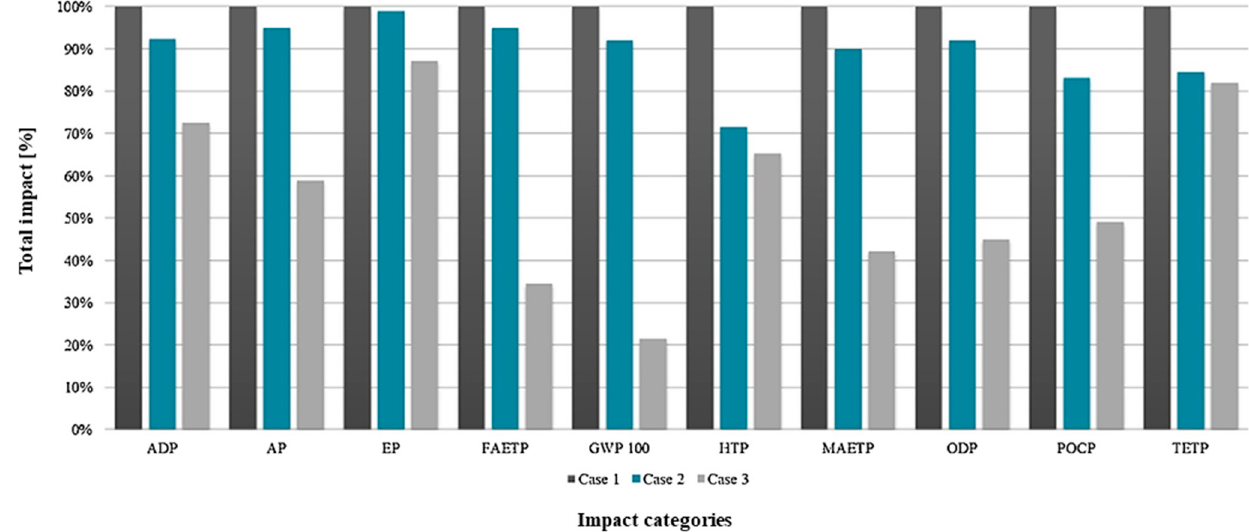
Figure 5. The comparative LCA results for the three cases: (Case 1) alkali-catalyzed with virgin soybean oil, (Case 2) enzyme-catalyzed with virgin soybean oil, and (Case 3) enzyme-catalyzed with WCO. The main impact categories were: Abiotic Depletion Potential (ADP), Global Warming Potential (GWP), Ozone Layer Depletion Potential (ODP), Human Toxicity Potential (HTP), Fresh Water Aquatic Ecotoxicity Potential (FAETP), Marine Aquatic Ecotoxicity Potential (MAETP), Terrestrial Ecotoxicity Potential (TETP), Photochemical Ozone Creation Potential (POCP), Acidification Potential (AP), and Eutrophication Potential (EP) [76].